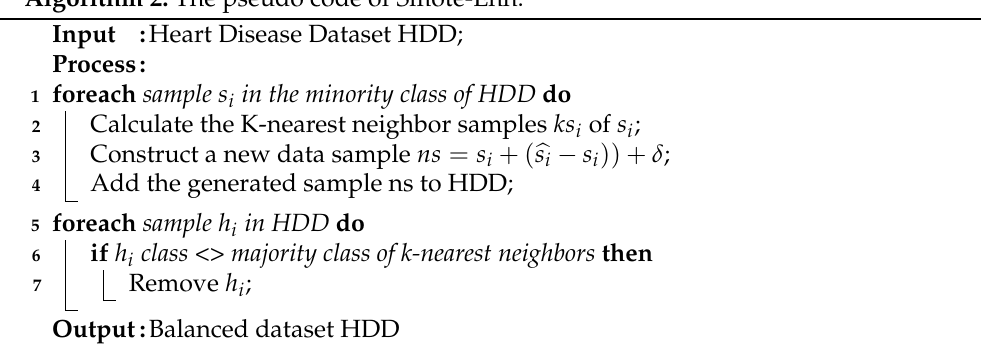
Algorithm 2: The pseudo code of